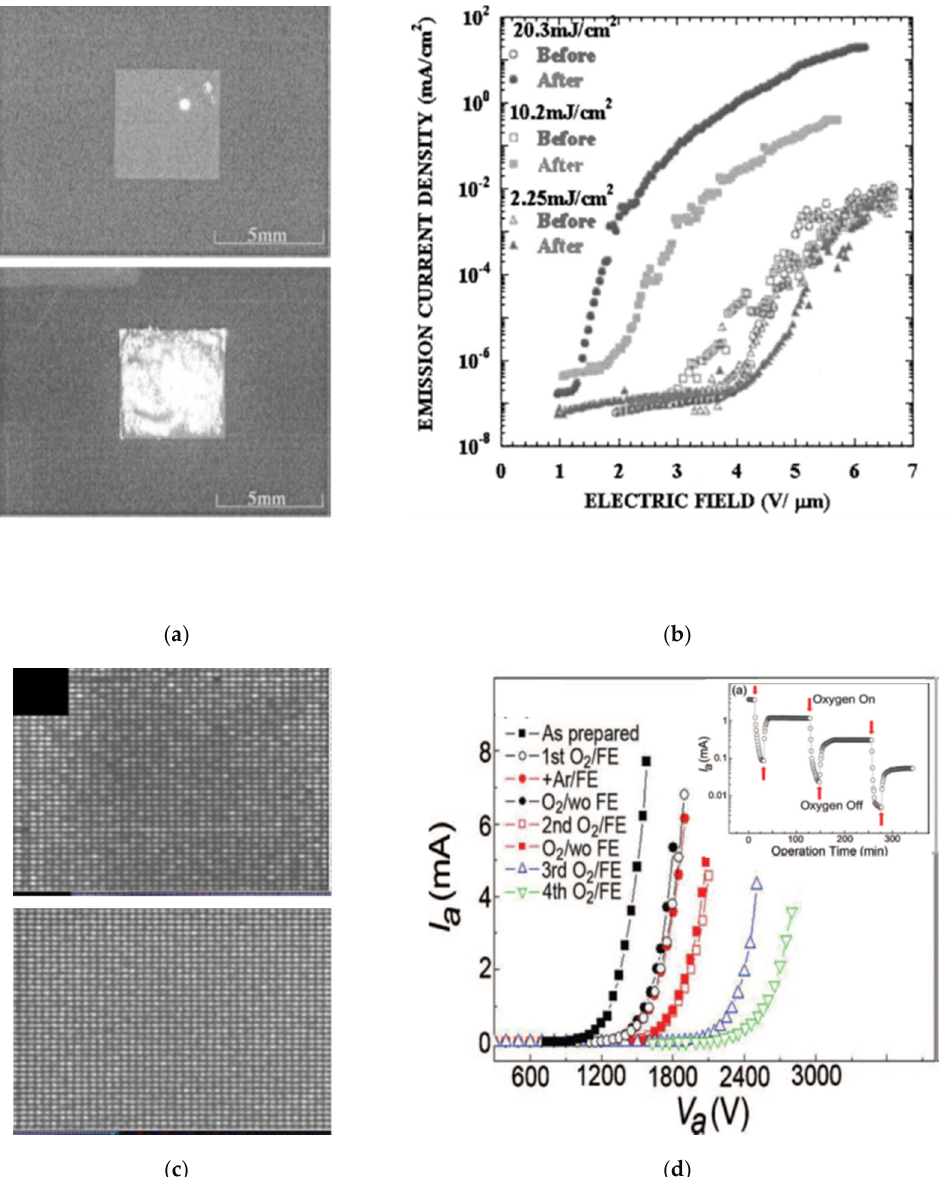
Figure 13. Emission enhancement by a postprocess treatment: ( a , c ) the pair of emission patterns from CNT FE cathode arrays before (upper view), and after laser irradiation (lower view); ( b , d ) the FE characteristic of the cathodes before and after laser irradiation. The inset in ( d ) shows the cathode operation at a periodic O2 supply, i.e., oxygen trimming is on or off. Figure 13a,b reprinted with permission from [131], and Figure 13c,d reprinted with permission from [132].